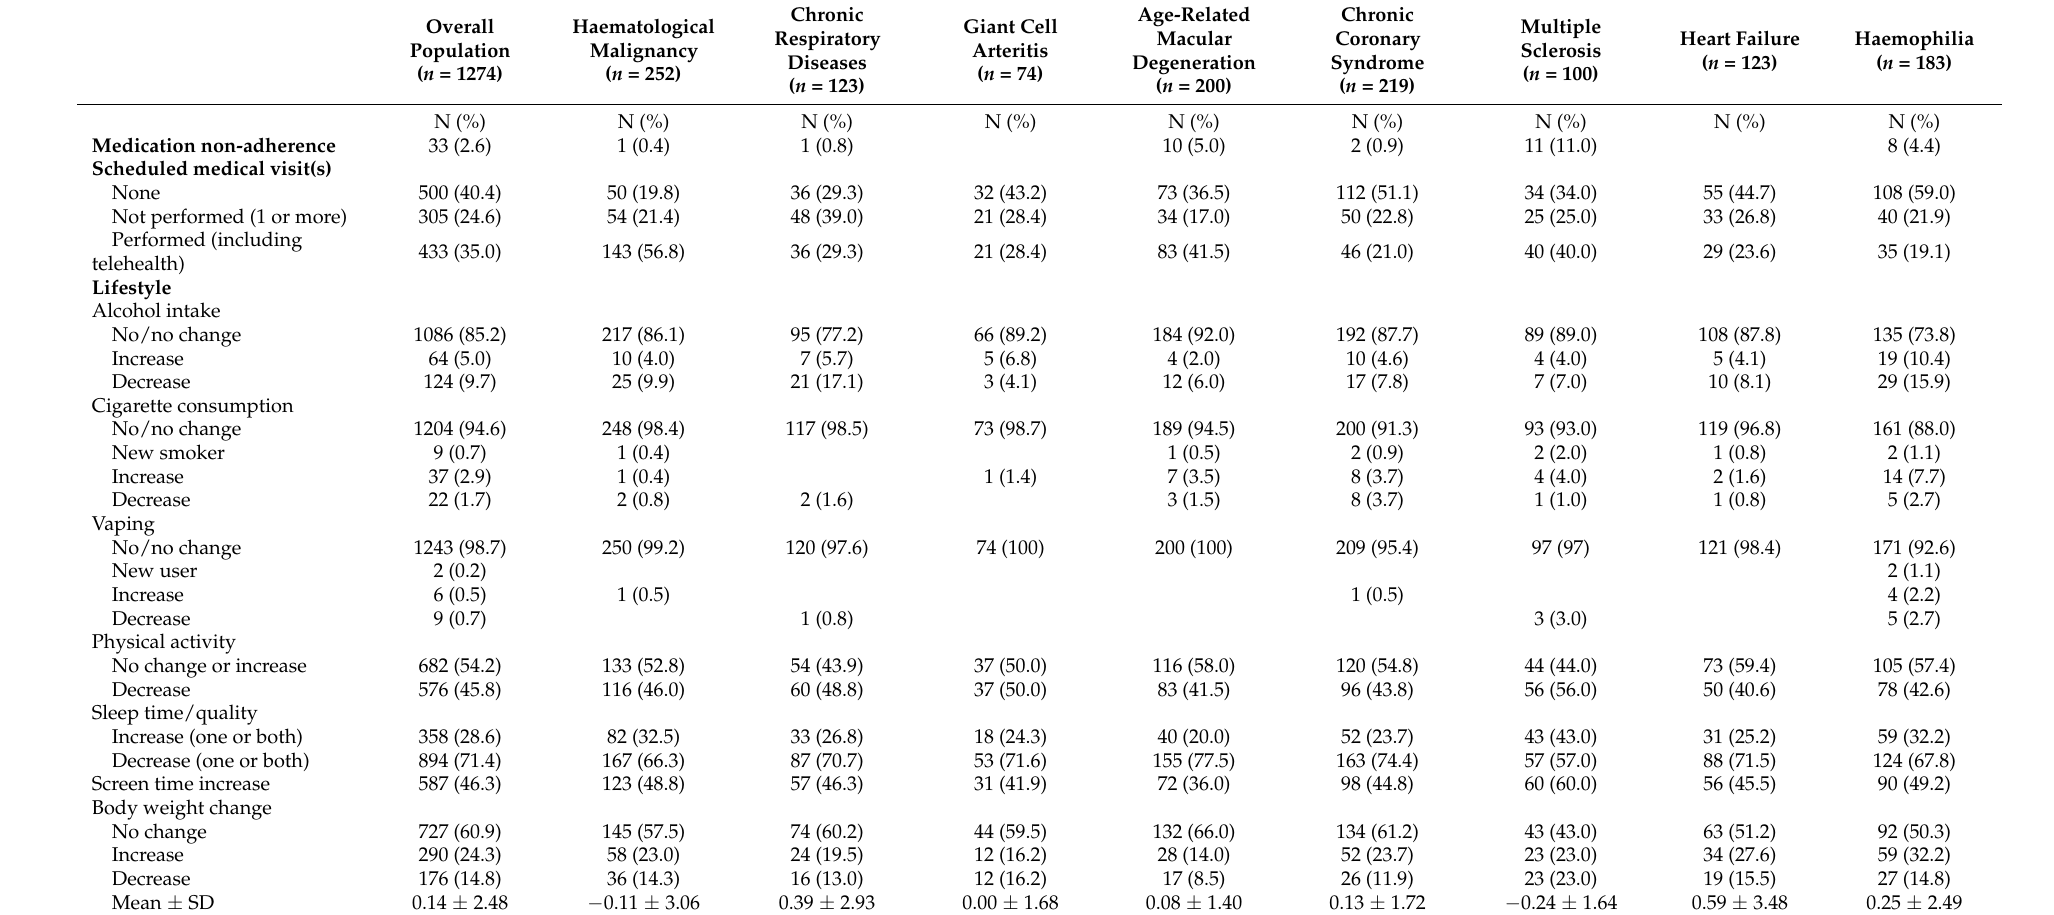
Table 2. Patient impact of COVID-19-related